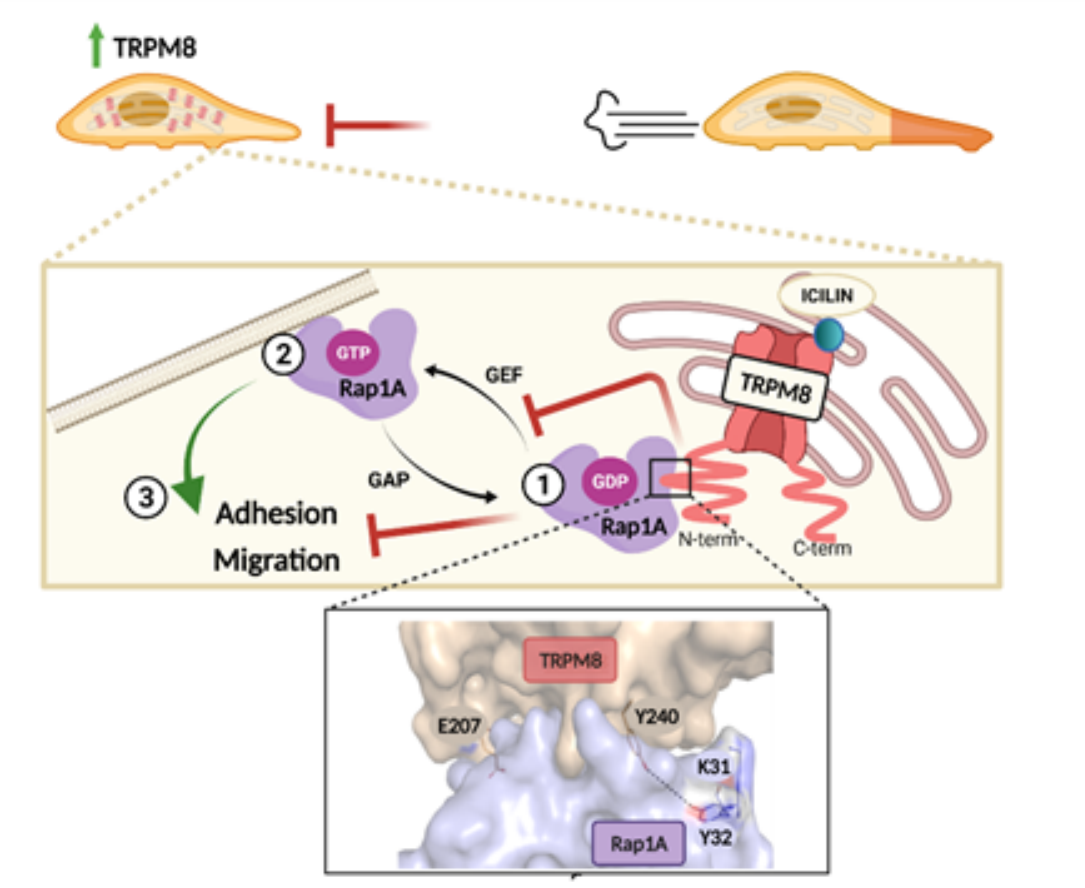
Figure 10. Scheme summarizing the mechanism through which TRPM8 inhibits cell adhesion and migration thanks to the direct interaction with the small GTPase